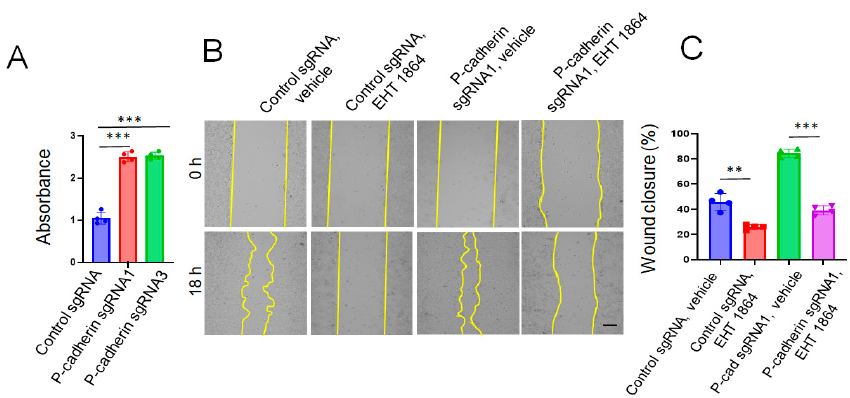
Table S1), encode regulators of cell migration, adhesion and actin cytoskeleton remodel- by controlling multiple molecular and signaling pathways in IEC.